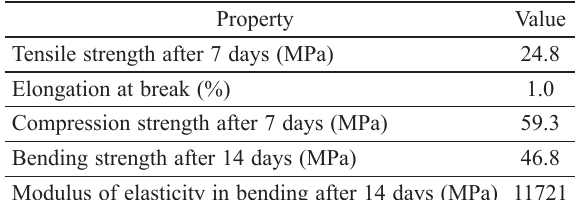
Table 3. Typical data of mechanical properties of epoxy resin (Curing conditions: 23 °C and 50% R.H.)